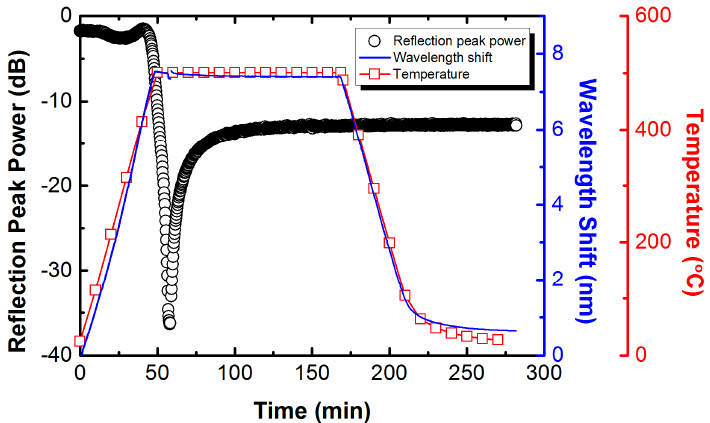
Figure 1. Typical evolution of the reflection peak power and the Bragg wavelength shift of one grating with the corresponding temperature profile during annealing for fabrication of the regenerated fiber Bragg grating (RFBG) in H 2 -loaded PS1250/1500 fiber.